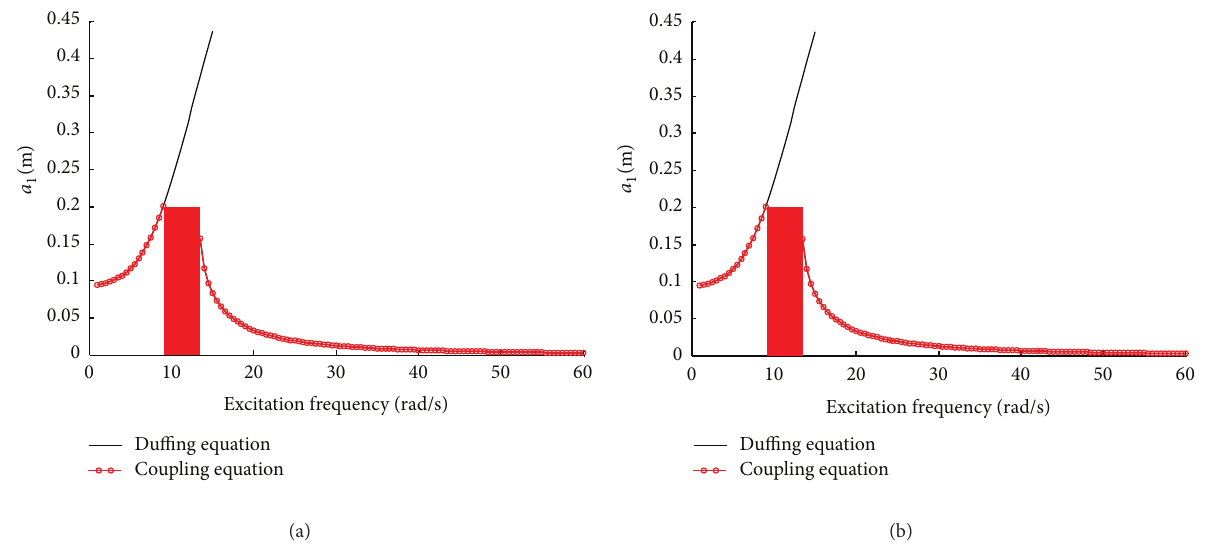
Figure 5: Influence of the plate’s vibration on the vibration properties of the oscillator ( 𝑘 3 = 10𝑘 1 ); the shadow range is the unstable range: (a) the influence on 𝑎 1 and (b) the influence on 𝑎 3 .